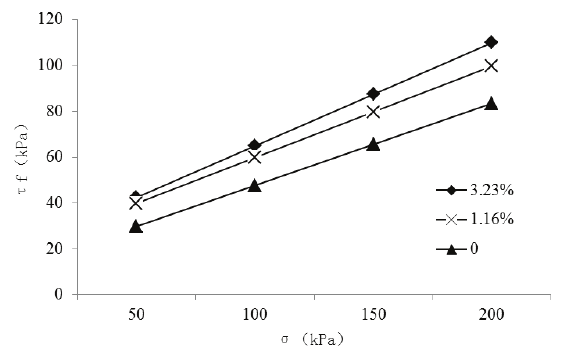
Figure 11: Trend of shear strength of dry red soil with different plant root